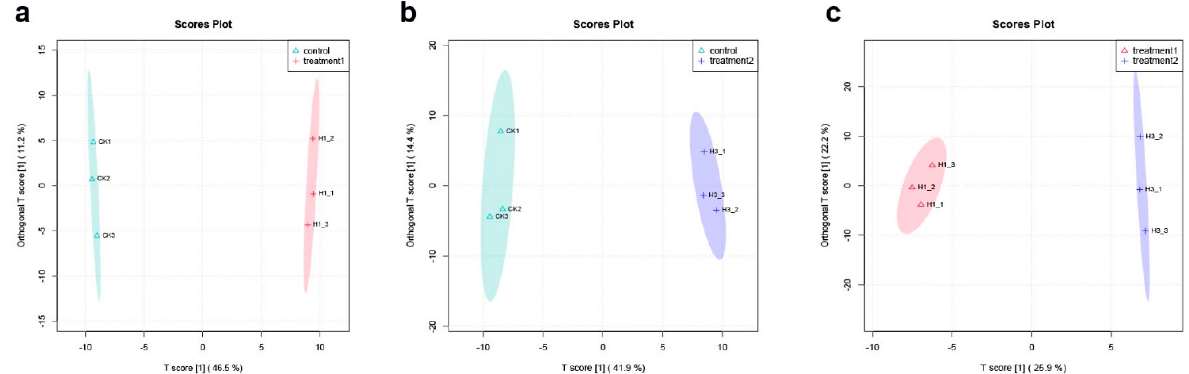
groups of CK vs. H1, ( b ) comparison groups of CK vs. H3, ( c ) comparison groups of H1 vs. H3. CK, control group; H1, group with heat stress treatment for 1 d; H3, group with heat stress treatment for 3